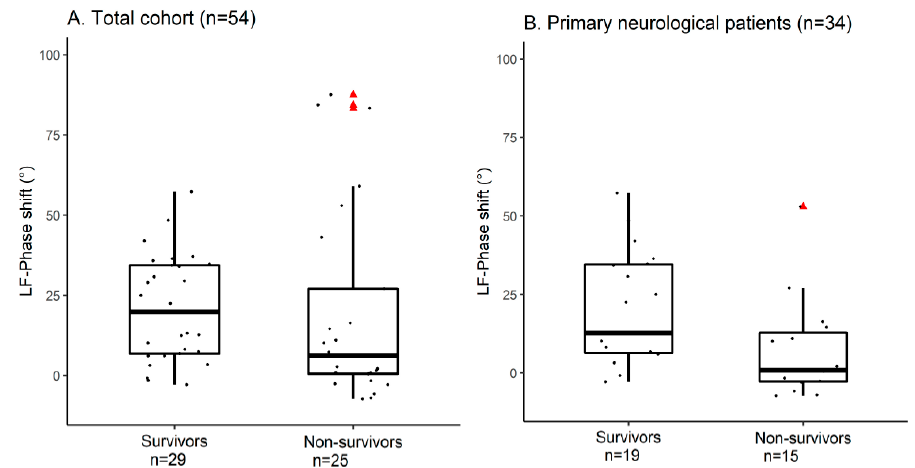
Figure 3. Low frequency phase shift dichotomized for six-month mortality. The boxplots in ( A ) show for the total cohort no significant difference between survivors and non-survivors for the LF-phase shift (survivors 20 ◦ (q1–q3 6.7–34) versus non-survivors 6.2 ◦ (q1–q3 0.51–27), p = 0.118, n = 54). Three outliers ( ∆ in the non-survivor group (LF-phase shift > 75 ◦ ) were identified. These three patients had the admission diagnosis: respiratory insufficiency ( n = 2) and hemorrhagic shock ( n = 1). ( B ) shows the boxplots for patients with a primary neurological admission diagnosis. A significant difference between survivors and non-survivors for the LF-phase shift (survivors 13 ◦ (q1–q3 6.3–35) versus non-survivors 0.83 ◦ ( − 2.8–13), p = 0.0167, n = 34) is presented. The outlier ( ∆ in the non-survivor group (LF-phase shift = 52 ◦ ) was a multi-trauma patient with only mild brain injury involvement who was intubated because of respiratory insufficiency. deoxyHb = deoxyhemoglobin; LF = low frequency range; oxyHb = oxyhemoglobin; q1–q3 = interquartile range; ∆ = data